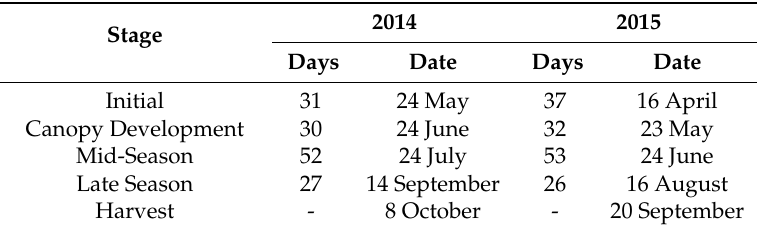
Table 2. Dates of crop growth stages.